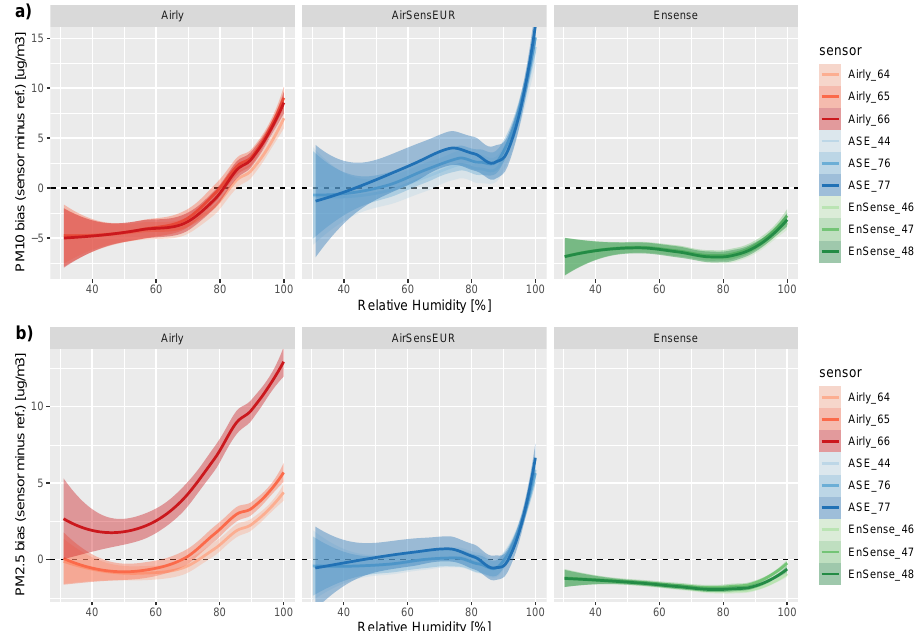
Figure 10. Absolute bias for ( a ) PM 10 and ( b ) PM 2.5 as a function of relative humidity. Each line shows the Loess fit to the respective hourly observations. Note that the data from the long-range transport episode in early October were removed from the underlying